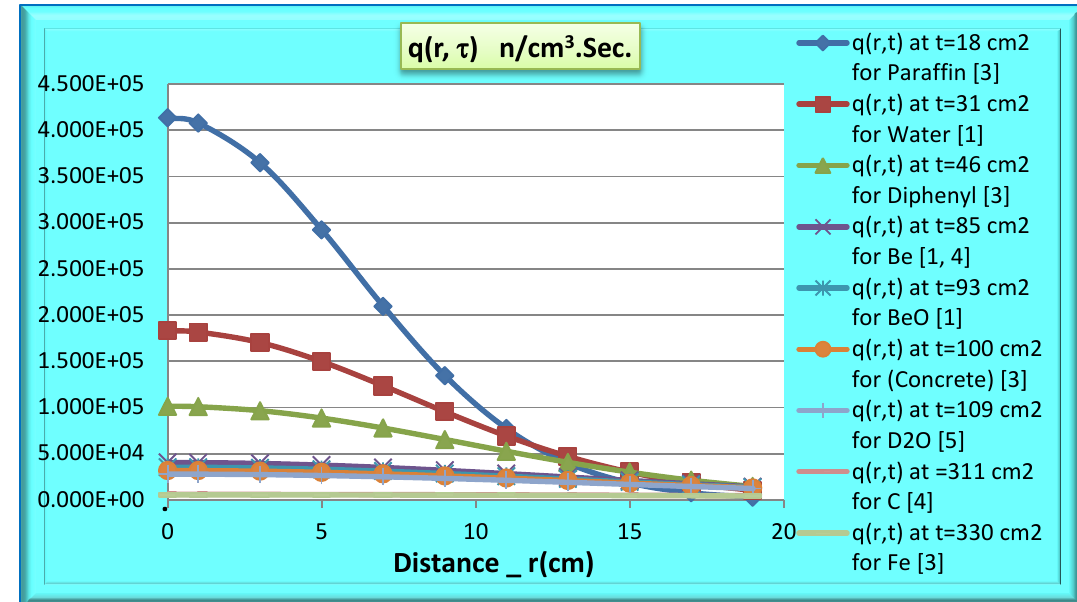
Fig. 1: The slowing down density for various materials as a function of position (r) from the neutron